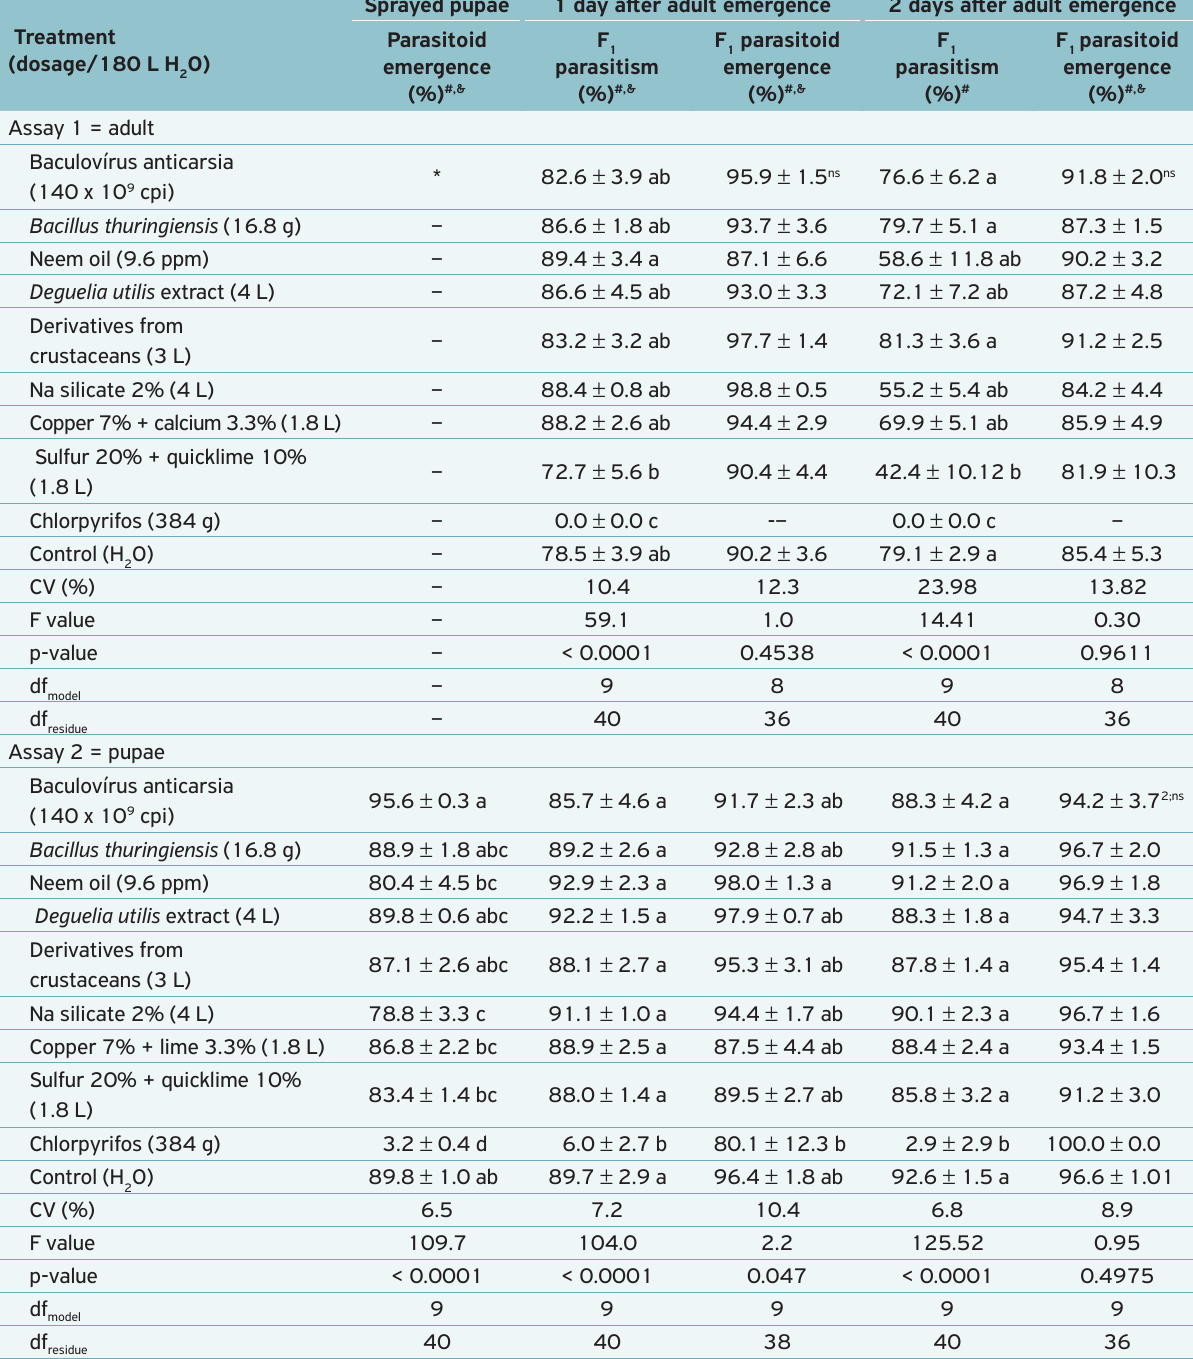
Table 2. Side effects of organic agricultural supplies sprayed on the egg parasitoid Trichogramma pretiosum.